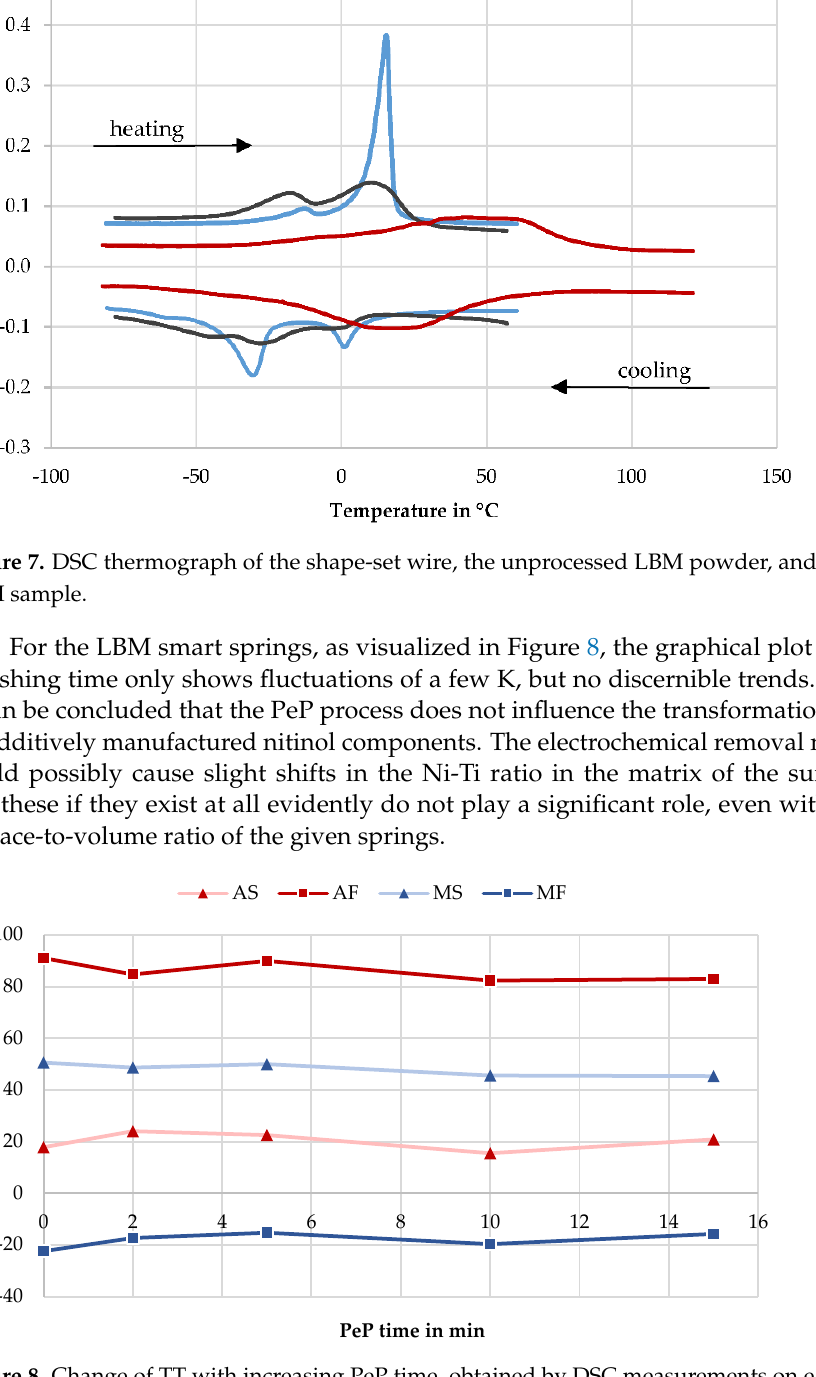
Figure 8. Change of TT with increasing PeP time, obtained by DSC measurements on each sample.